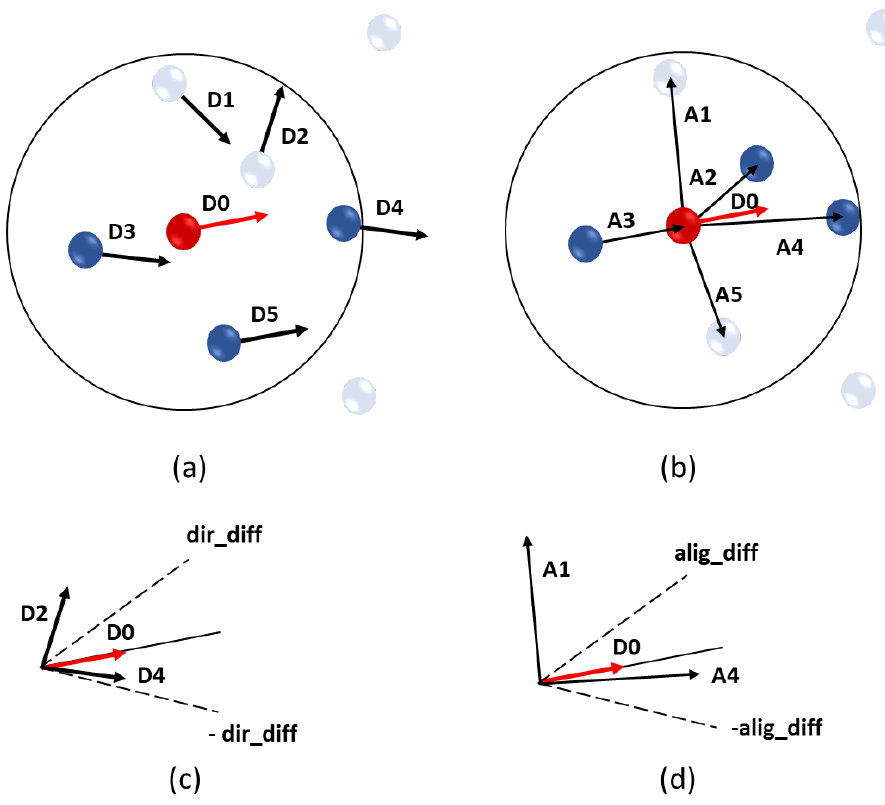
Figure 5. ( a ) Comparison of seed point and neighbors’ direction. ( b ) Direction compatibility thresholds. ( c ) Comparison of seed point direction and alignment with neighbors ( d ) Alignment compati- bility.